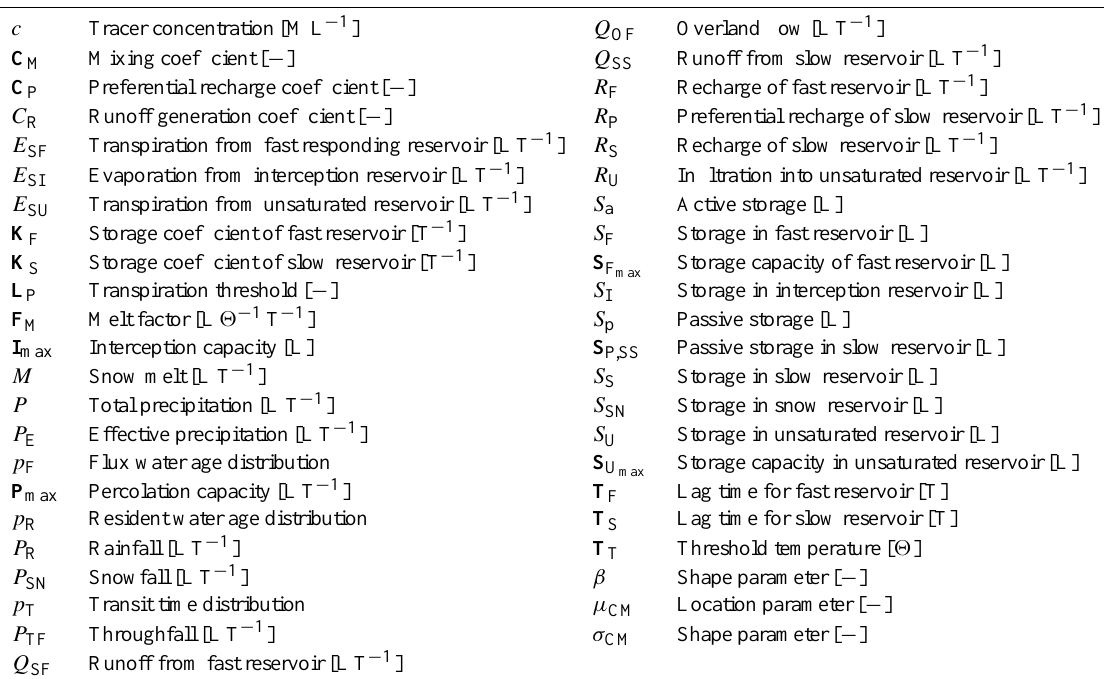
Table A1. List of